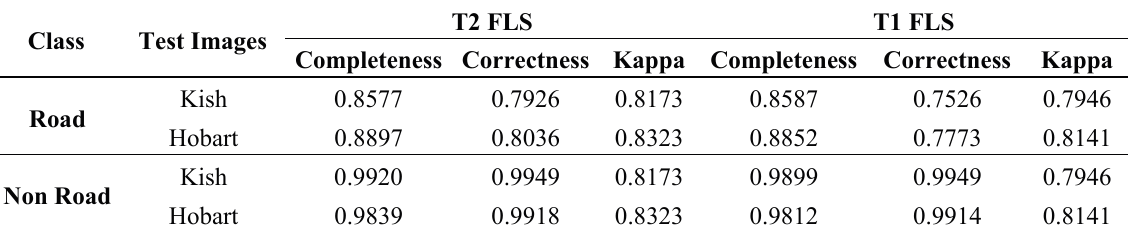
Table 5. Tuned FLSs accuracy evaluation for testing data